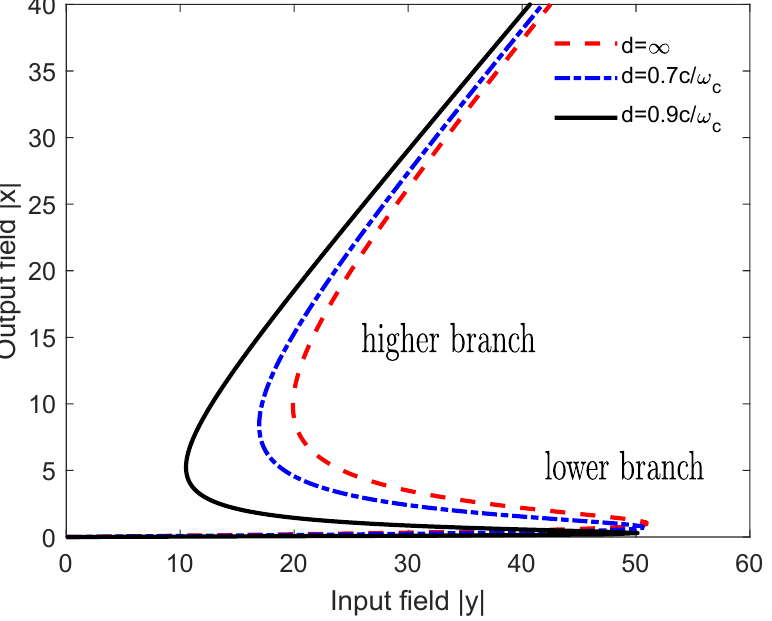
Figure 2. Plots of the input–output field curves for the quantum V -system. The dashed curve corresponds to the case of a medium of sole quantum emitters, i.e., d = ∞ , in which case, the decay rate is Γ 0 . The dot-dashed ( d = 0.7 c / ω c ) and solid ( d = 0.9 c / ω c ) curves correspond a quantum- sample medium (emitter + metasurface) with ¯ ω = 0.632 ω p . We assumed that ω 32 = 0, r = 0, C = 100 and δ =